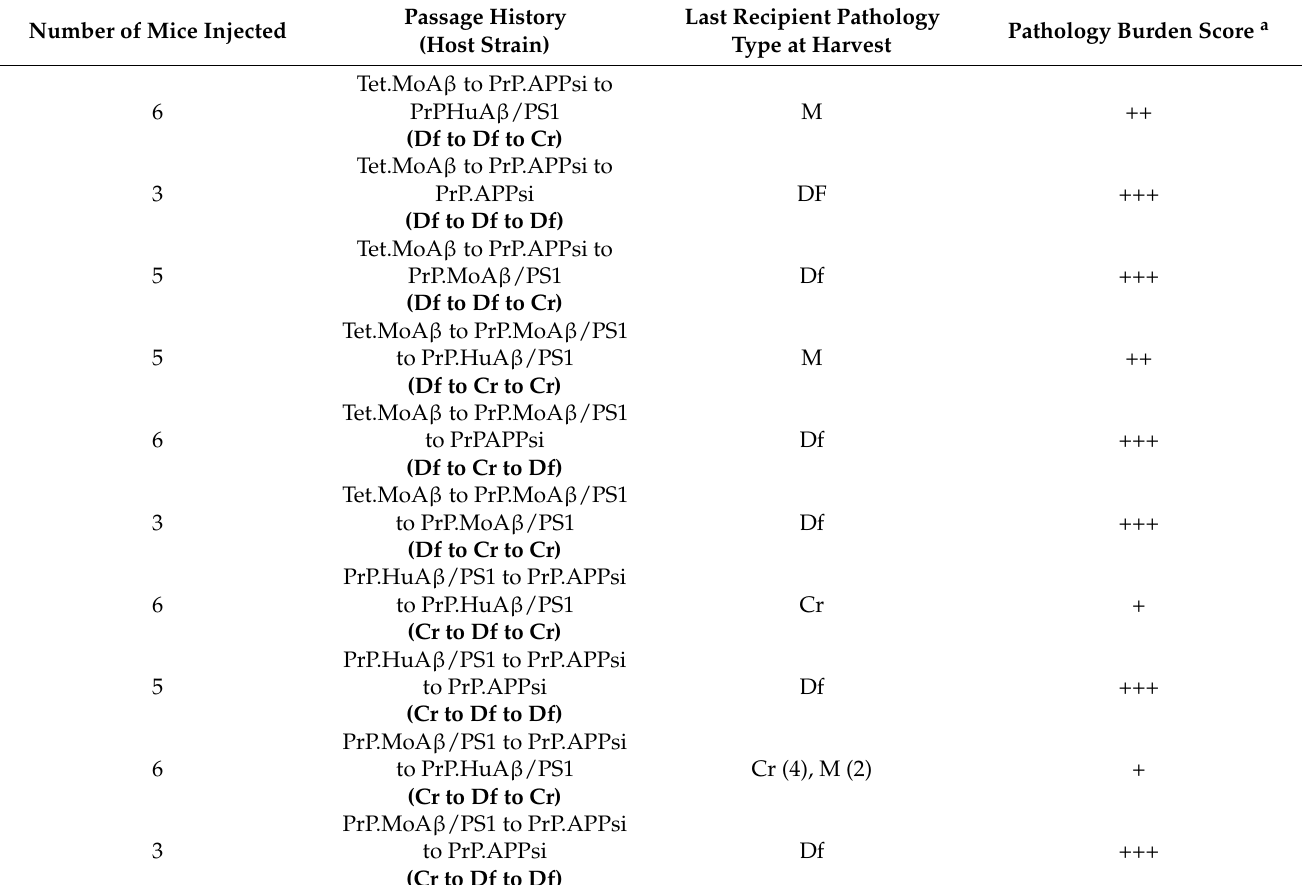
Table 3. Summary of serial passage cohort data results; Cr-core plaques, Df-diffuse plaques, M-mixed. Passage Number of Mice Injected